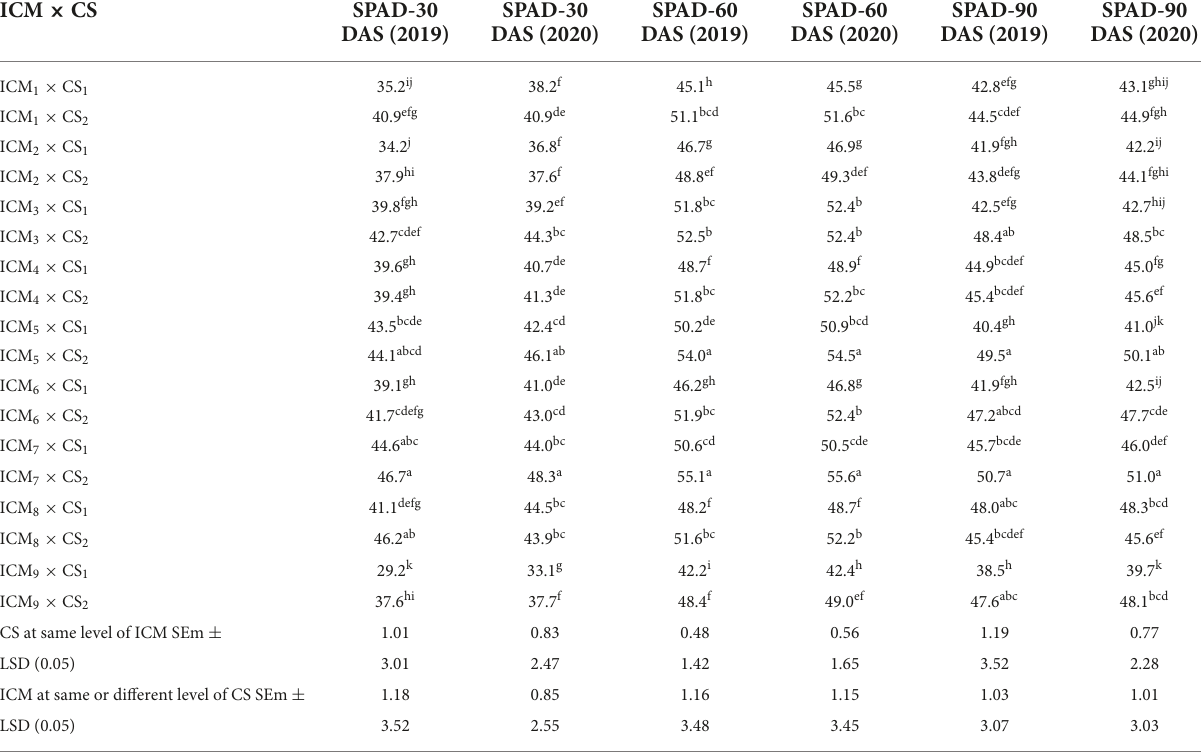
TABLE 6 Integrated crop management (ICM) modules × cropping system (CS) interaction effects on SPAD values of maize at 30-days interval DAS under maize a . ICM ×